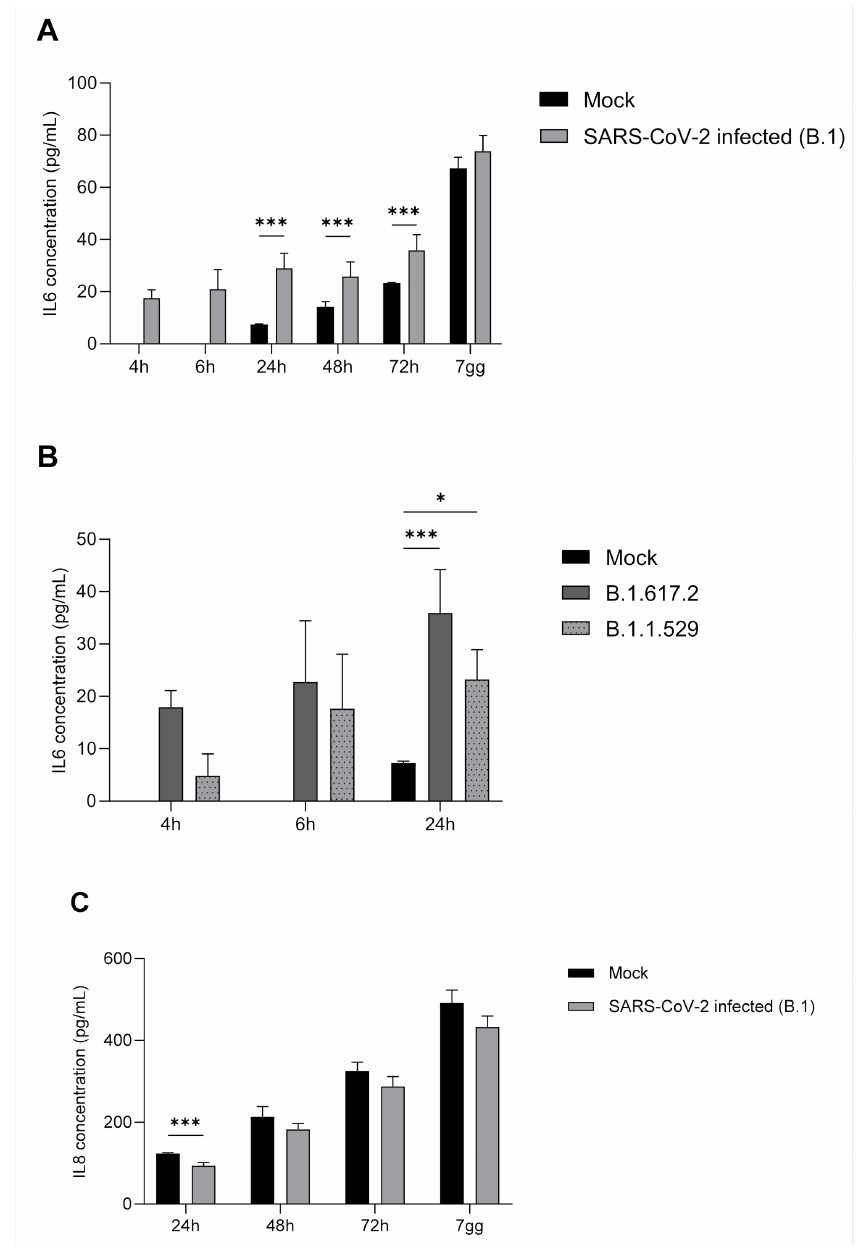
Figure 6. IL-6 and IL-8 evaluation in supernatant of SARS-CoV-2 infected HMEC-1 by ELISA test. IL-6 concentration (pg/mL) in SARS-CoV-2 infected supernatants at 4 h, 6 h, 24 h, 48 h, 72 h, and 7 days p.i. for the B.1 strain (panel ( A )). Significant IL-6 higher expression was observed in infected cells at 24 h, 48 h, and 72 h p.i. (*** p < 0.001) compared to non-infected cells. IL-6 expression at 4 h, 6 h, and 24 h p.i. for the B.1.617.2 and B.1.1.529 strains. Significant IL-6 higher expression was observed at 24 h for both strains (*** p < 0.001 and * p < 0.05 for B.1.617.2 and B.1.1.529, respectively) (panel ( B )). IL-8 concentration (pg/mL) in uninfected and SARS-CoV-2 infected supernatants. Significant IL-8 lower expression was observed in infected cells at 24 h p.i.; *** p < 0.001 (panel ( C